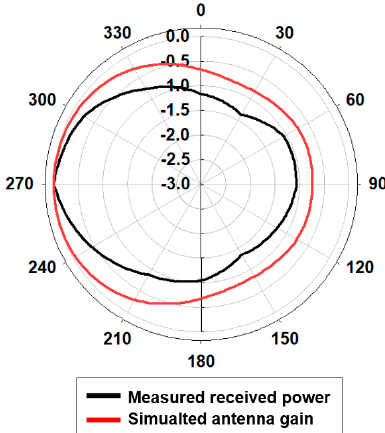
Figure 12. Measured received power and simulated antenna gain at θ = 90° and φ = 270°.